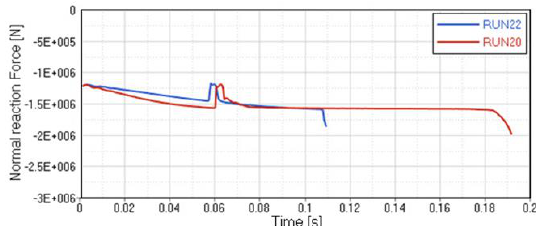
Figure 12. % Thinning distribution and X1, X2, Y1 and Y2 values for the RUN11; blank1.